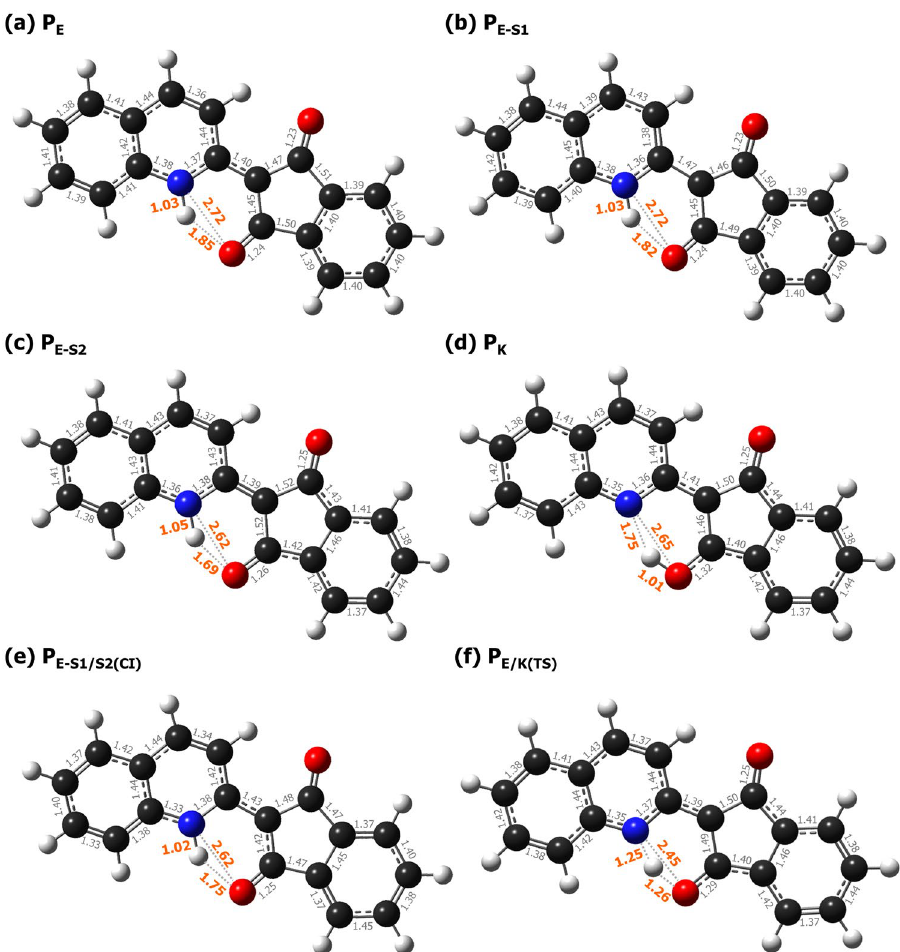
Figure 5. Point geometry of ( a ) ground state of E form, ( b – d ) local minima at the first singlet excited state, ( e ) conical intersection between S 0 /S 1 of the E form, ( f ) transition state between the E and K tautomer (units in angstrom